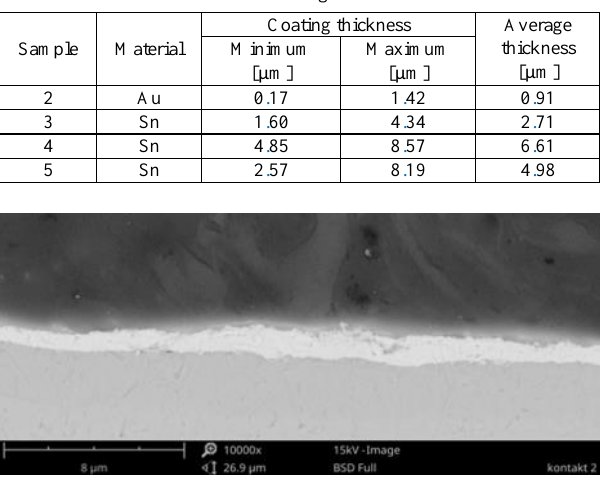
Fig. 2. Scanning microscope image of sample number 2 – a continuous, well-made coating of variable thickness, a substrate for coating applica-